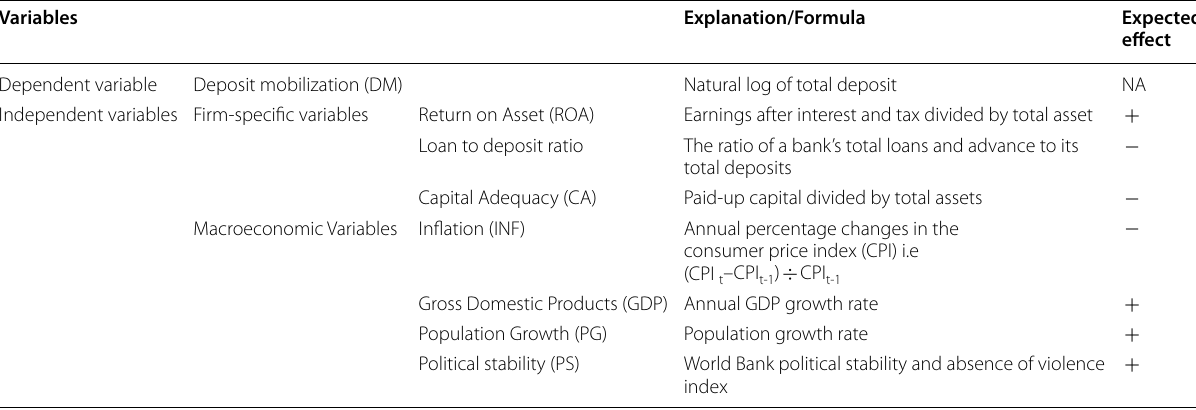
Source : Developed based on the literature